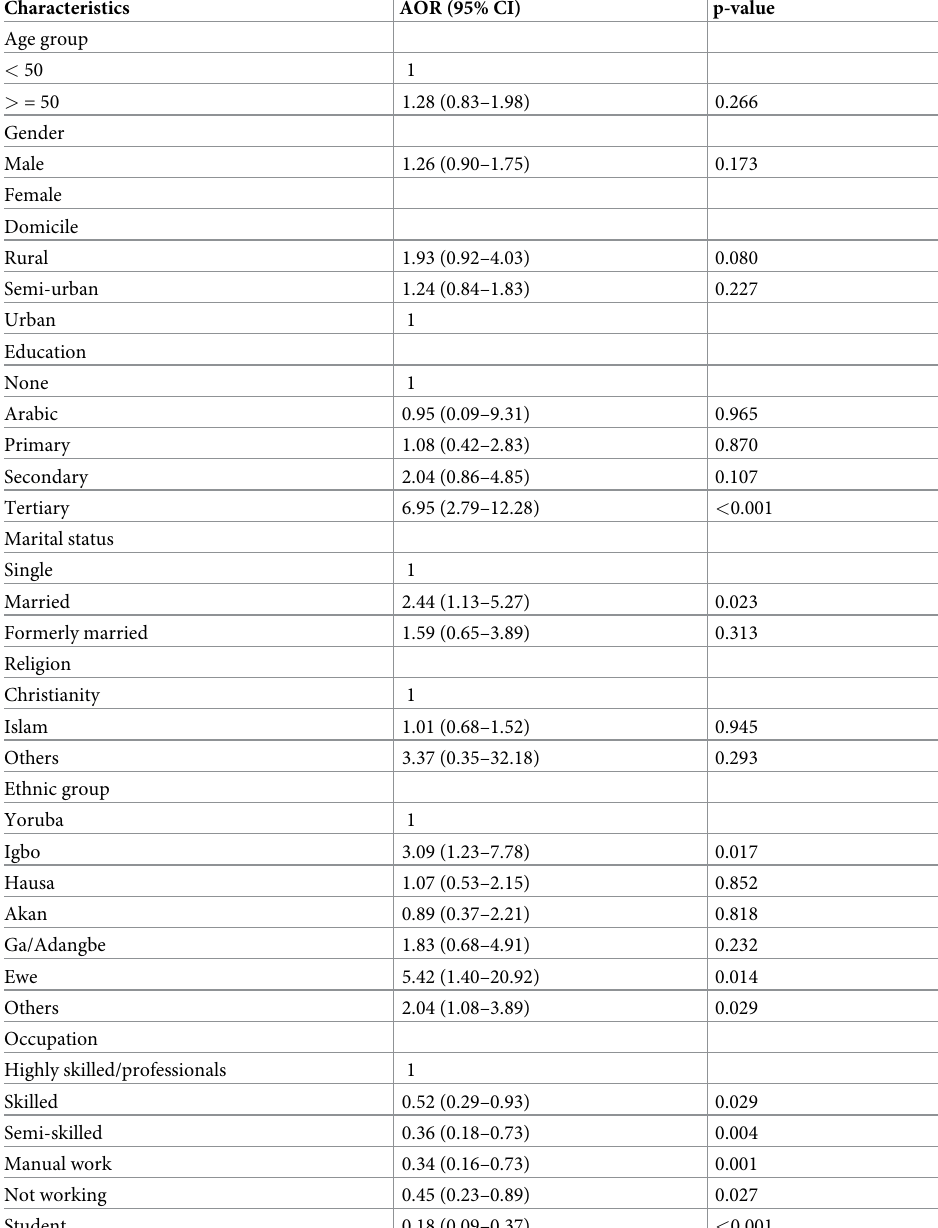
Table 7. Association of socio demographic characteristics and awareness of consent